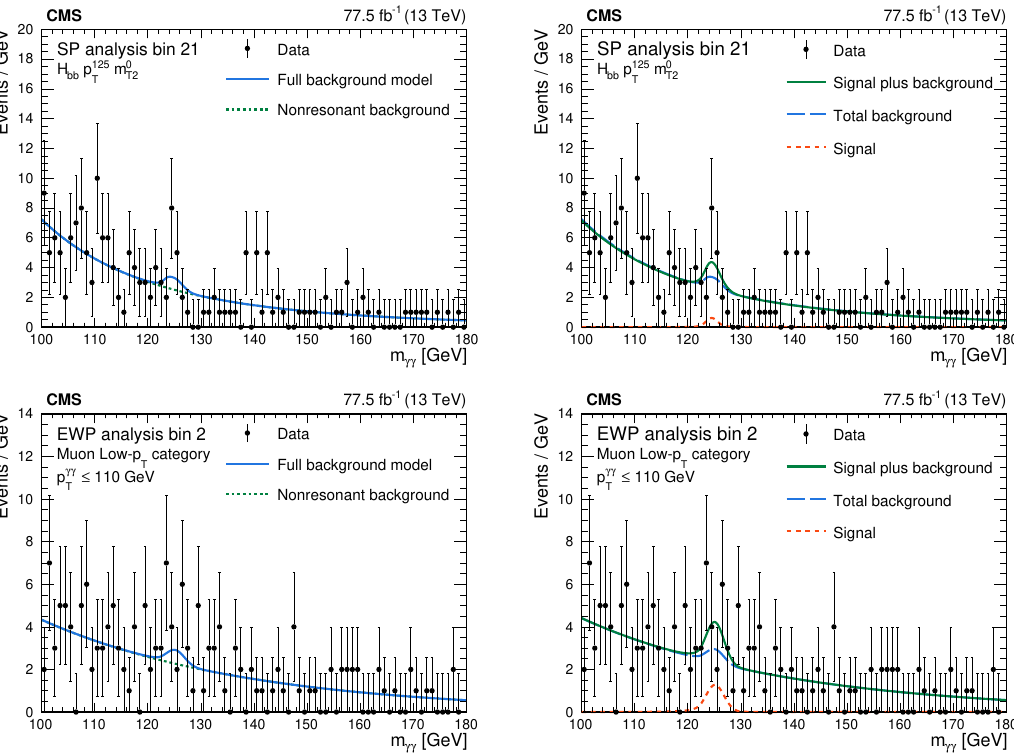
Figure 2 . The diphoton mass distribution for two example search bin is shown with the background-only (cid:12)t (left) and the signal-plus-background (cid:12)t (right) to illustrate the signal ex- traction procedure. The search region bins shown corresponds to the Hb(cid:22)b p 125 21, of the SP analysis (upper) and the Muon Low- p T category, bin 2, of the EWP analysis (lower).